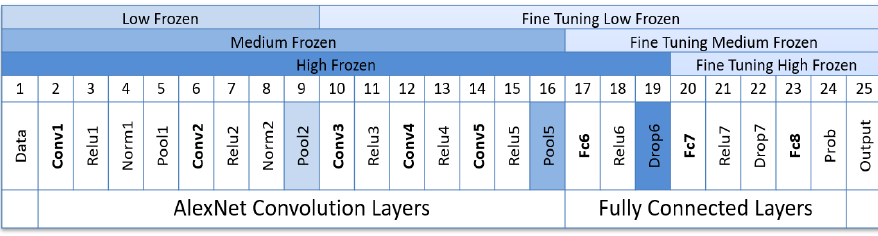
Figure 4. Example diagram of the three levels of freezing of the weights referred to the AlexNet layers.